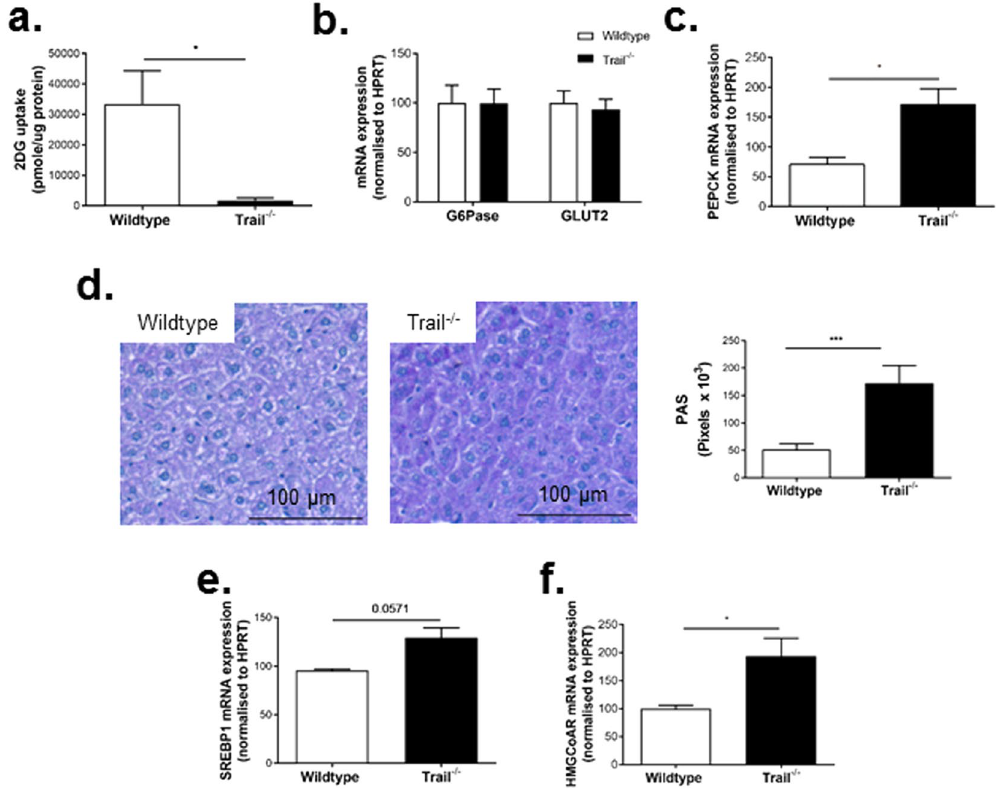
Figure 4. Liver from Trail − / − mice exhibit altered glucose and lipid metabolism. ( a ) Hepatic glucose uptake ex vivo is reduced in baseline 0 w HFD Trail − / − vs. wildtype mice (n = 3–5/genotype). mRNA expression for ( b ) Glucose-6 phosphatase (G6Pase) or GLUT2 mRNA in baseline mice. ( c ) Insulin-stimulated PEPCK mRNA expression is increased in baseline Trail − / − mice (n = 6/genotype). ( d ) 12 w HFD Trail − / − mice exhibit increased PAS staining and have ( e ) elevated SREBP-1 and ( f ) HMGCoAR mRNA expression (n = 6/genotype). mRNA expression was normalized to HPRT. Results are expressed as mean ± SEM; Mann-Whitney U -test; * p < 0.05, and *** p <